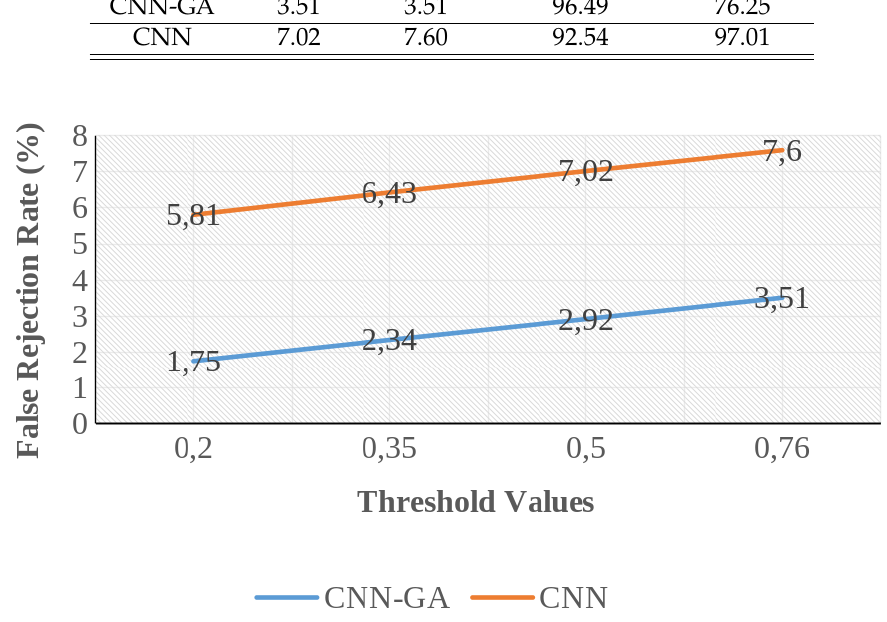
Table 2: Cz<omparison of CNN and CNN-GA at 128 by 128-pixel resolution at 0.76 threshold value Algorithm